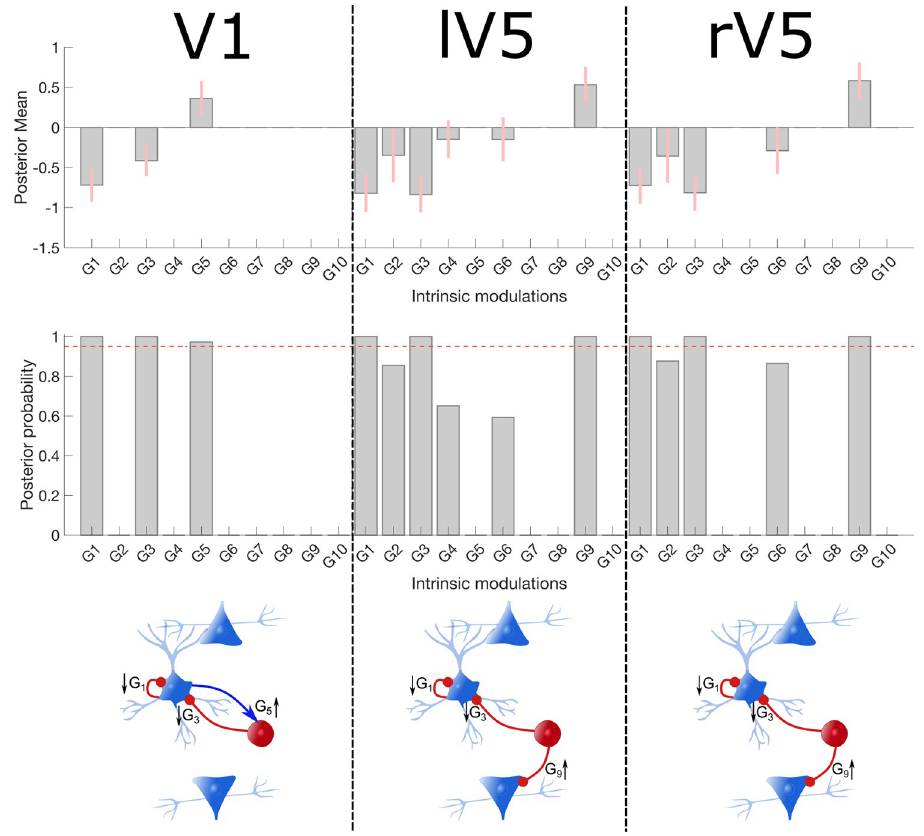
Fig 5. Intrinsic connectivity modulations. The figure reports the group-level results of the intrinsic connectivity modulations associated with EC states (relative to EO) in the three sources of interest. More specifically, the mean posterior and 90% Bayesian confidence interval (pink error bars) after the greedy search algorithm and Bayesian model averaging are shown in the top row. The middle row shows the corresponding posterior probabilities of the intrinsic modulations, the pink dotted lines correspond to a Pp of .95. Finally, the bottom is a schematic presentation of the modulation with Pp > .95 and the direction of the effect. Inhibitory connections are shown in red and excitatory in